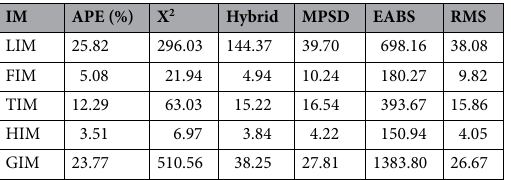
Table 3. Best match some error function values of the IM to the experimental results of the removal of AY11 dye by PPAC.